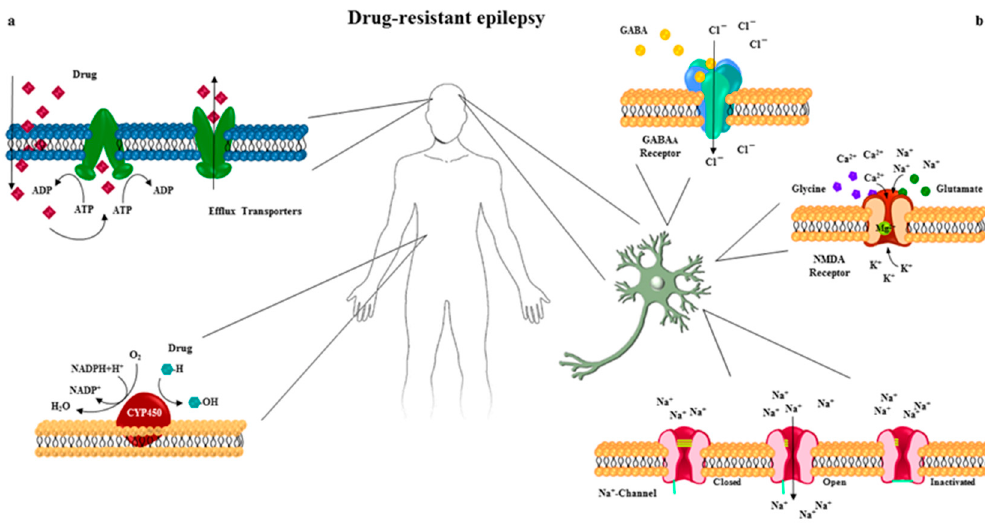
Figure 1. Schematic representation of the main pharmacokinetic ( a ) and pharmacodynamic processes ( b ) of antiepileptic drugs involved in refractory epilepsy. Mutations in genes encoding molecular targets could cause structural and/or functional alterations responsible for the lack of response to pharmacological treatment.